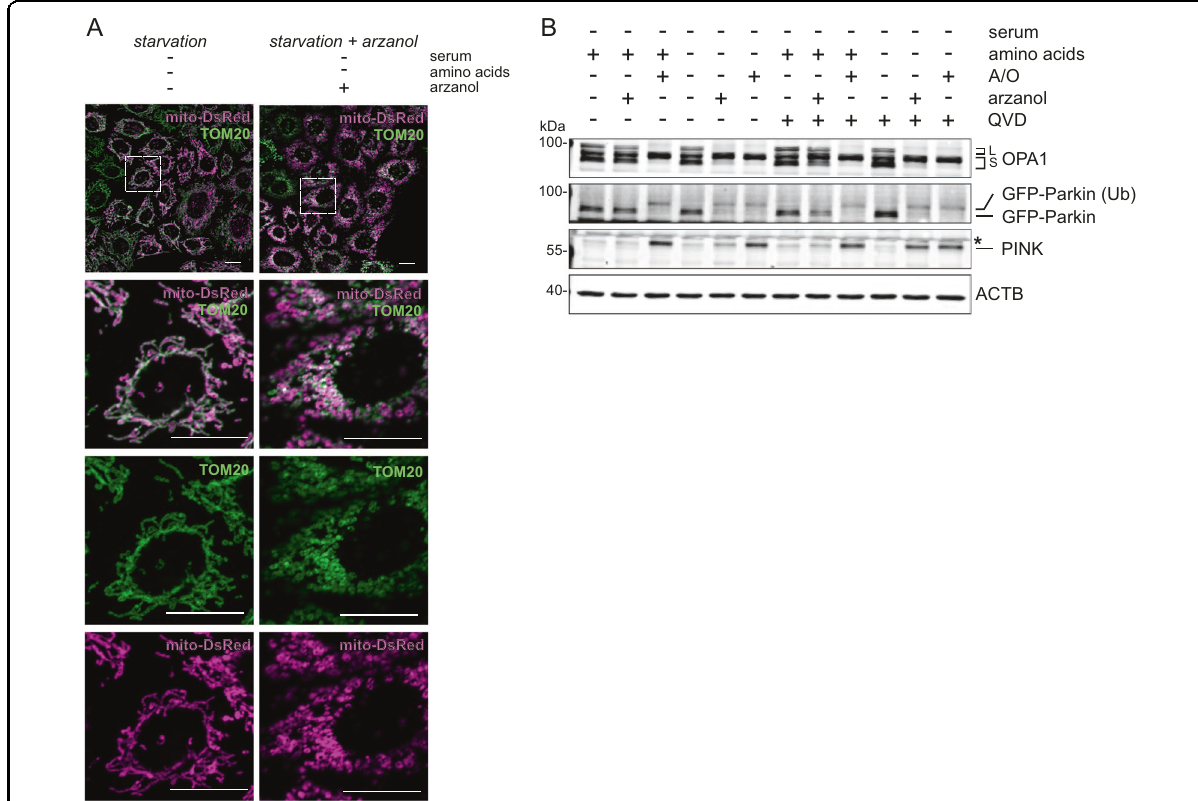
Fig. 5 Arzanol causes damage-induced fragmentation of mitochondria during starvation. A Shown are microscopy images of mito-DsRed- expressing HeLa cells immuno fl uorescently labeled for endogenous TOM20. During starvation, arzanol induces fragmentation of both inner (mito- DsRed) and outer (TOM20) mitochondrial membranes. Cells were starved in serum- and amino acid-free medium for 2 h while incubated with 5 µM arzanol. Scale bars in all panels are 20 µm. B Immunoblot for markers of mitochondrial damage (OPA1 cleavage, Parkin ubiquitination (Ub), PINK accumulation) reveals that arzanol-induced mitochondrial fragmentation is independent of apoptosis induction. HeLa cells stably expressing mito- DsRed GFP-Parkin were incubated with serum-free full medium or starvation medium and treated with 5 µM arzanol or a combination of 4 µM antimycin and 10 µM oligomycin (A/O) with/without 10 µM QVD for 6 h. Shown blots are representative of three independent experiments. L and S indicate long and short forms of OPA1, respectively. Asterisk indicates an unspeci fi c